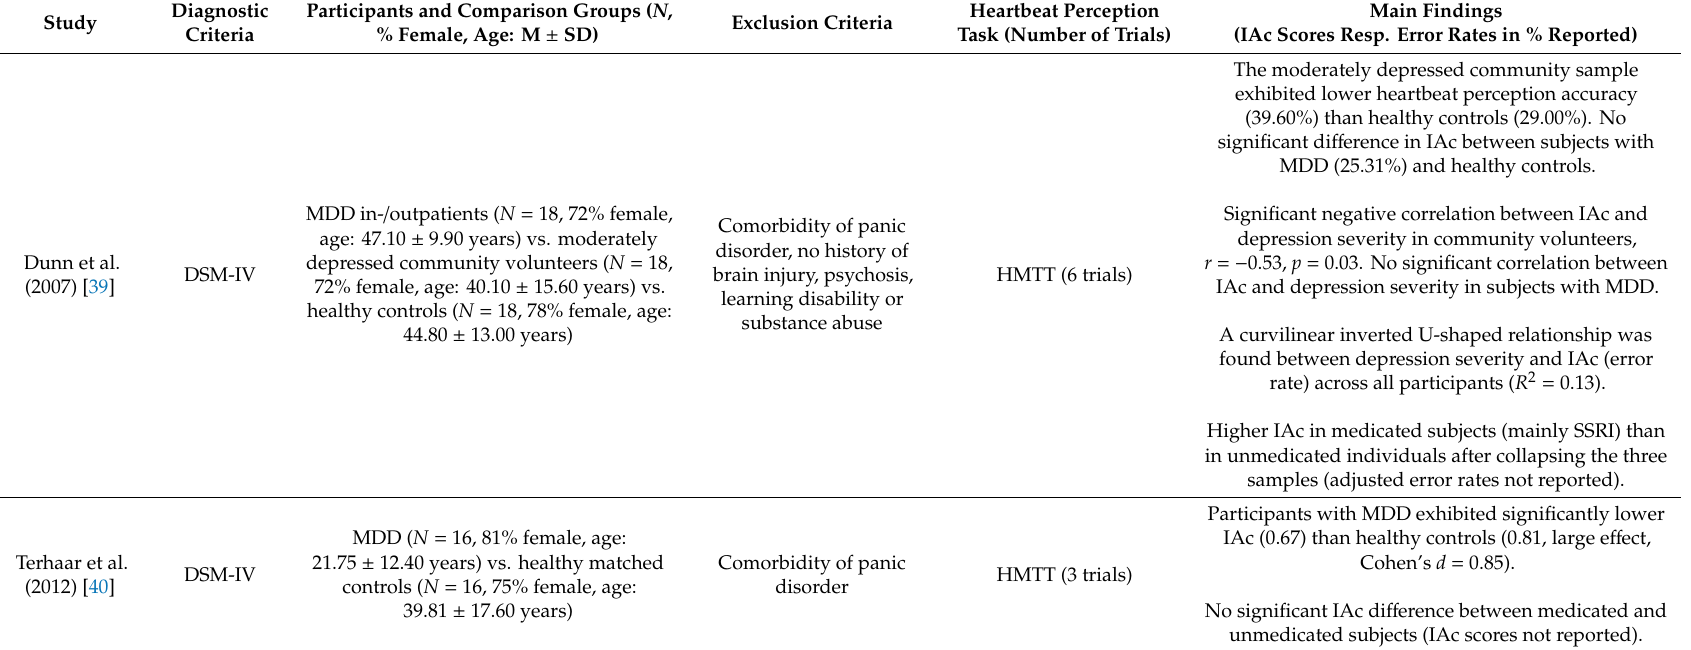
Table 1. Characteristics of included